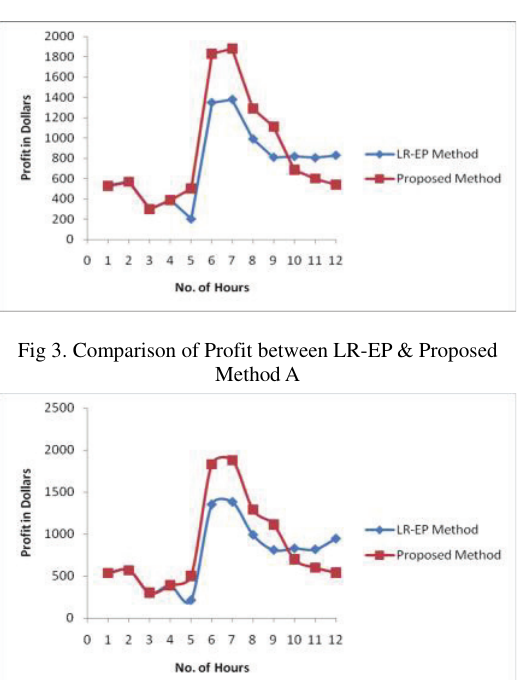
Fig 2. Effect of Probability of Reserve